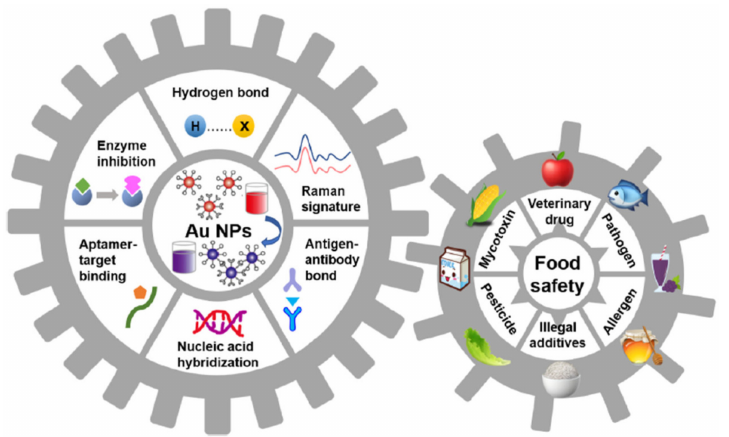
Figure 5. Schematic overview of different mechanisms of GNP-based biosensors for food safety detection (reprinted with permission from Ref. no. [87], copyright 2021,